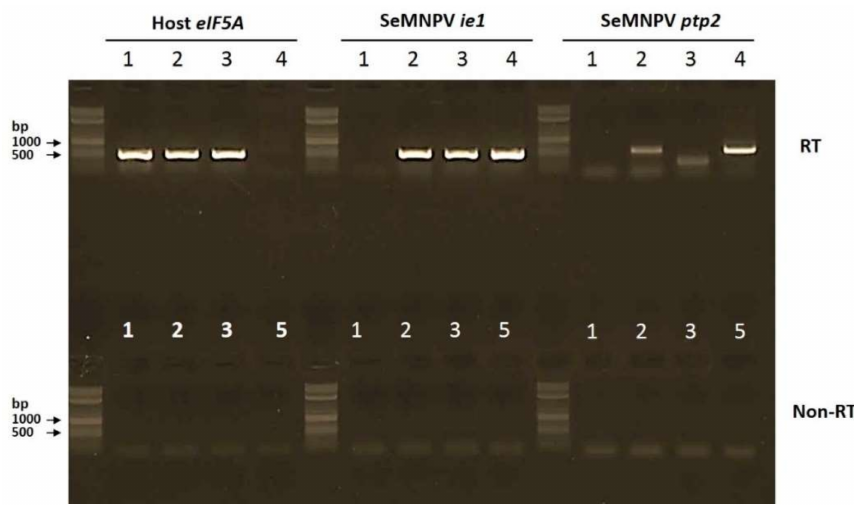
Figure 4. The full-length ptp2 gene is expressed in WT SeMNPV-infected but not in ∆ ptp2 SeMNPV-infected S. exigua larvae. RT-PCR analysis of mock-infected (1), WT SeMNPV-infected (2), or ∆ ptp2 SeMNPV-infected (3), S. exigua larvae processed for RT-PCR analysis at two days post infection. For each PCR a WT SeMNPV bacmid control (4) and a water control (5) were included. Expression of the host eIF5A gene, the SeMNPV ie1 gene and the SeMNPV ptp2 gene were analyzed. For each RT sample, a PCR without RT step (non-RT) was performed in parallel. The 2-Log DNA Ladder (0.1–10.0 kb, New England BioLabs Inc. Ipswich, MA, USA) was used in the agarose gel to estimate PCR fragment